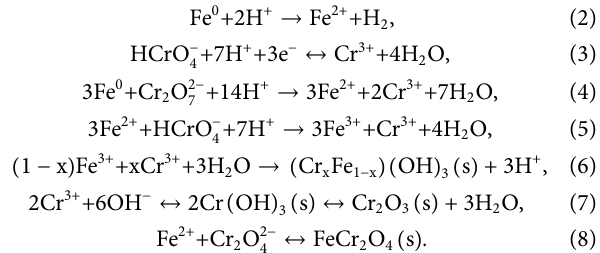
Figure S4 . The surface electrical charge of